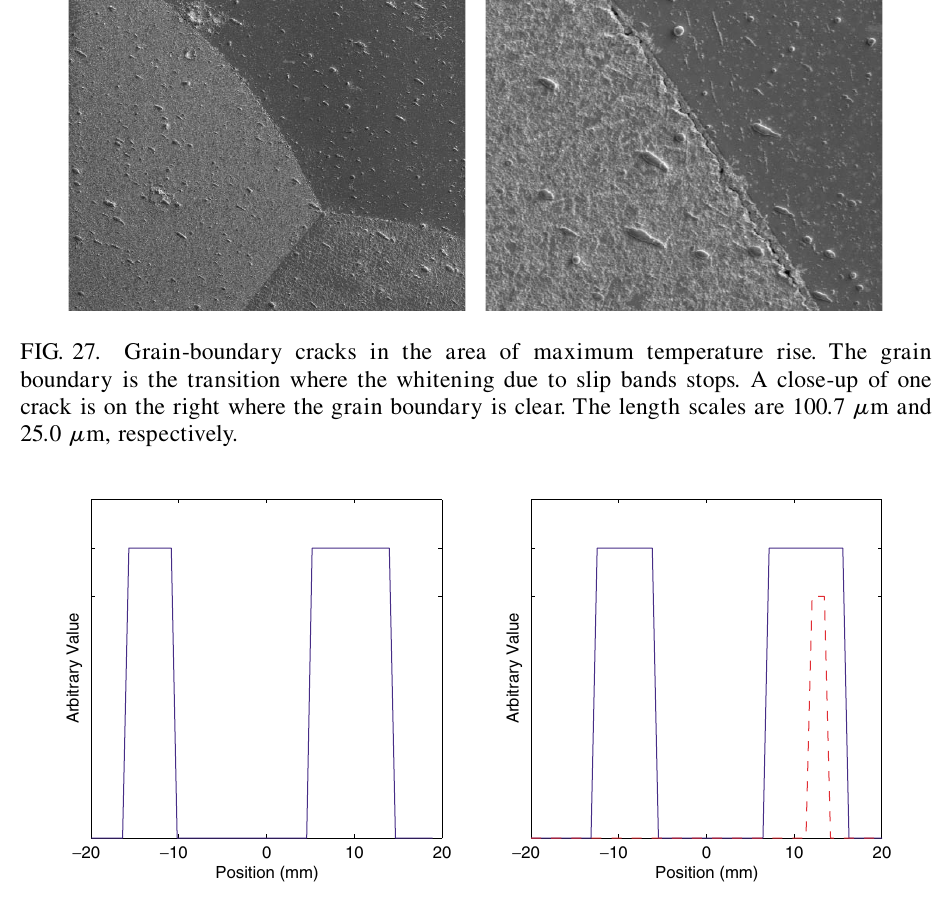
FIG. 28. (Color) Random scans along diameters of each end cap. The solid lines correspond to regions of surface roughening and the dotted lines are for regions that contain cracks on the surface. The centers of the end caps are at position 0 mm.